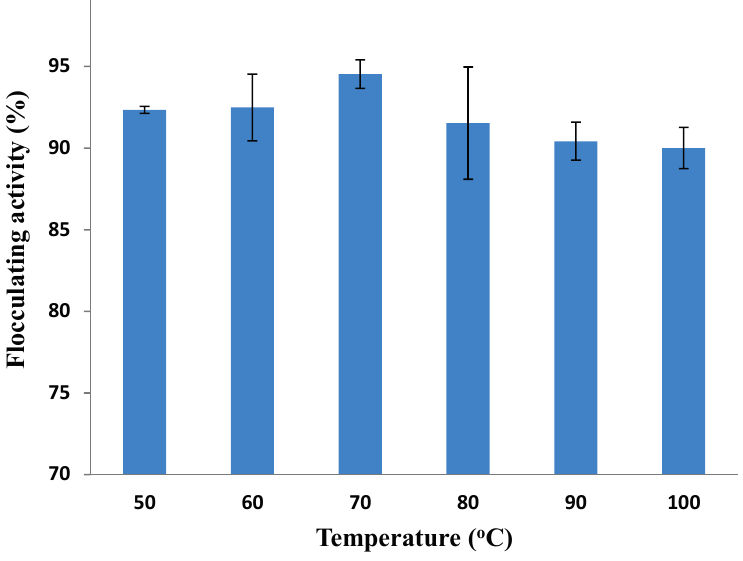
Figure 6. Thermal stability of purified MBF-UFH produced by Bacillus sp.